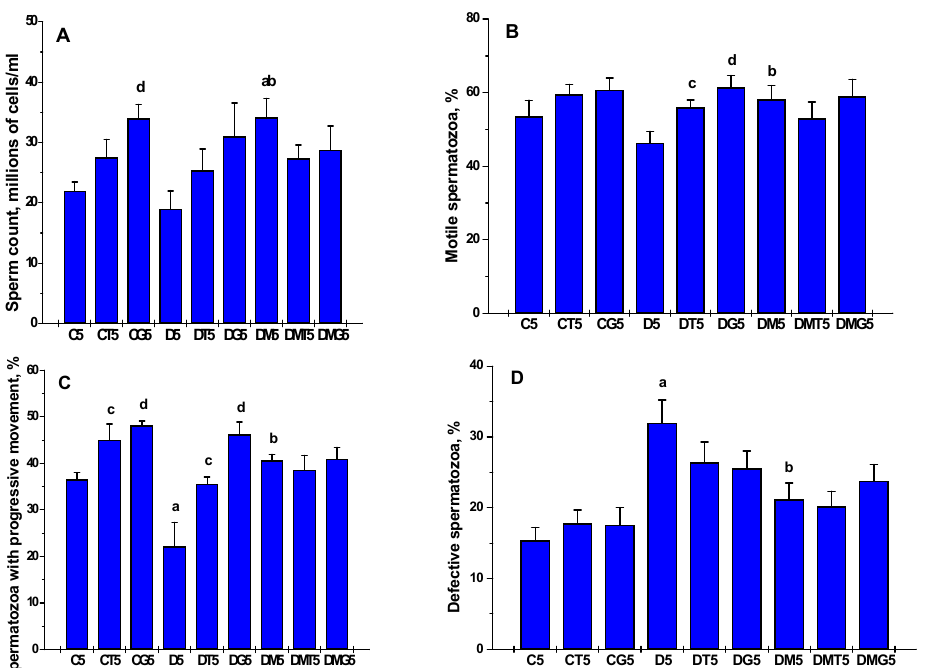
Figure 5. The effects of five-week metformin treatment, five-day treatment with LH/hCG-R-agonists and their combination on the sperm count ( A ), proportion of motile sperm ( B ), proportion of sperm with progressive movement ( C ), and proportion of sperm with tail and head morphological defects ( D ) in the control and diabetic rats. a —the difference between the C5 vs. D5 or DM5, b —the difference between the D5 vs. DM5; c —the difference between the C5 vs. CT5 and D5 vs. DT5; and d —the difference between the C5 vs. CG5 and D5 vs. DG5 are significant at p < 0.05. The data are presented as the M ± SEM, n = 5.